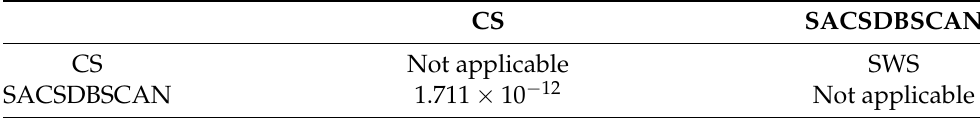
Table 11. p -values for instance 6.5.